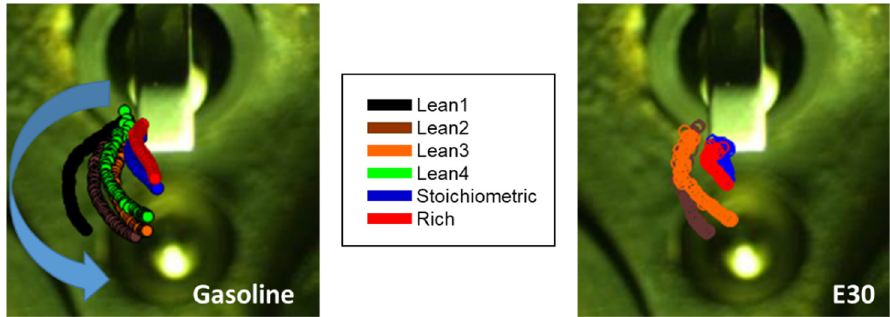
Figure 12. Trajectory of the flame luminosity center for gasoline (left) and E30 (right). The trajectories of the flame luminosity indicate that the flame propagation is influ- enced by the swirl motion. As reported in the computational work by Van Dam et al. [20], carried out on the same engine at two different operating conditions (throttled and un- vortex offset to the lower-right considering the present field of